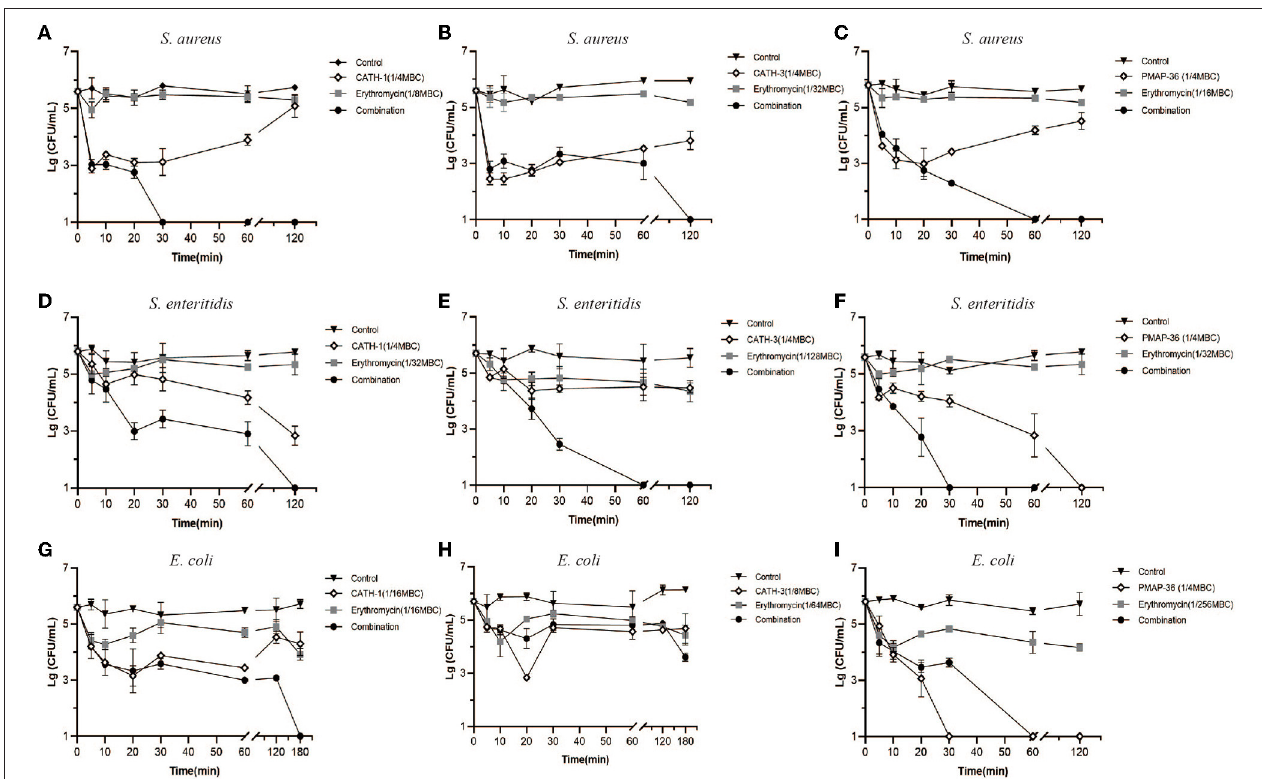
FIGURE 2 | Time-killing kinetics of antimicrobial peptides combination with erythromycin. Time-killing kinetics of CATH-1, CATH-3, and PMAP-36 combination with erythromycin against S. aureus (A–C) , S. enteritidis (D–F) , and E. coli (G–I) are